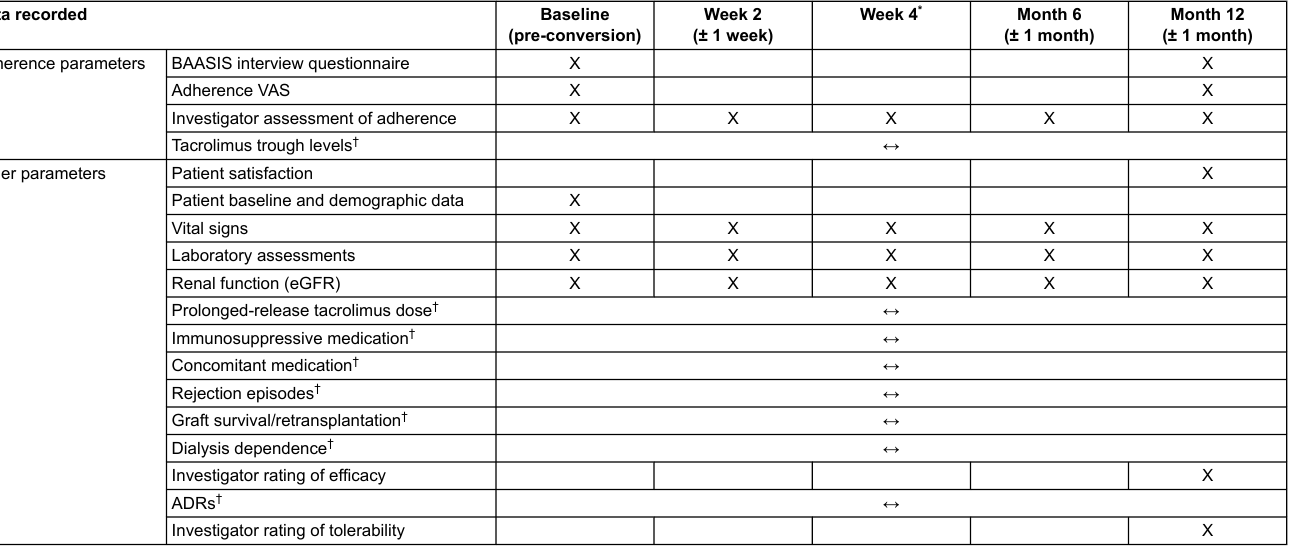
Table 1: Schedule of data collection. Data recorded Adherence parameters BAASIS interview questionnaire